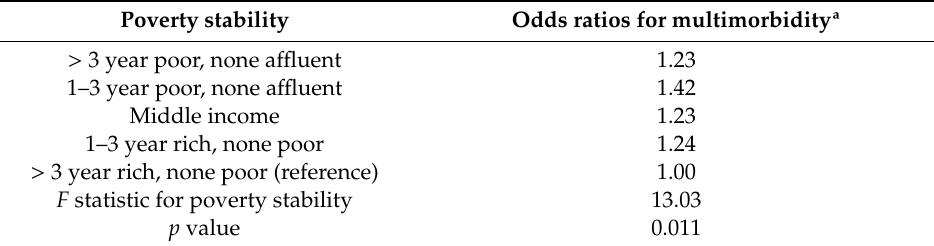
Table A2. Poverty stability and